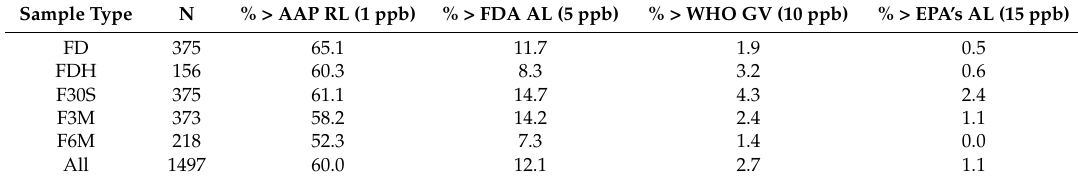
Table 5. Comparison of New Orleans WLLs (ppb) in normal use residential sites to